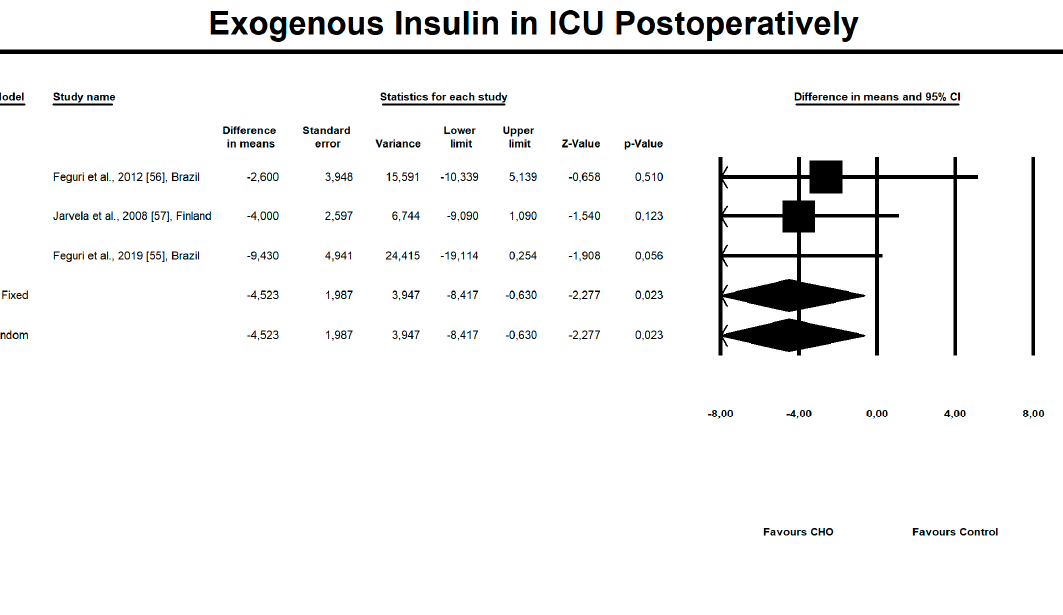
Figure 8. An effect size, risk ratio, for inotropic drugs use in patients taking oral carbohydrates (OCH) drinks vs. controls. Table 2. Qualitative clinical outcomes that were not subjected to meta ‐ analysis. Values are number of patients. Outcomes